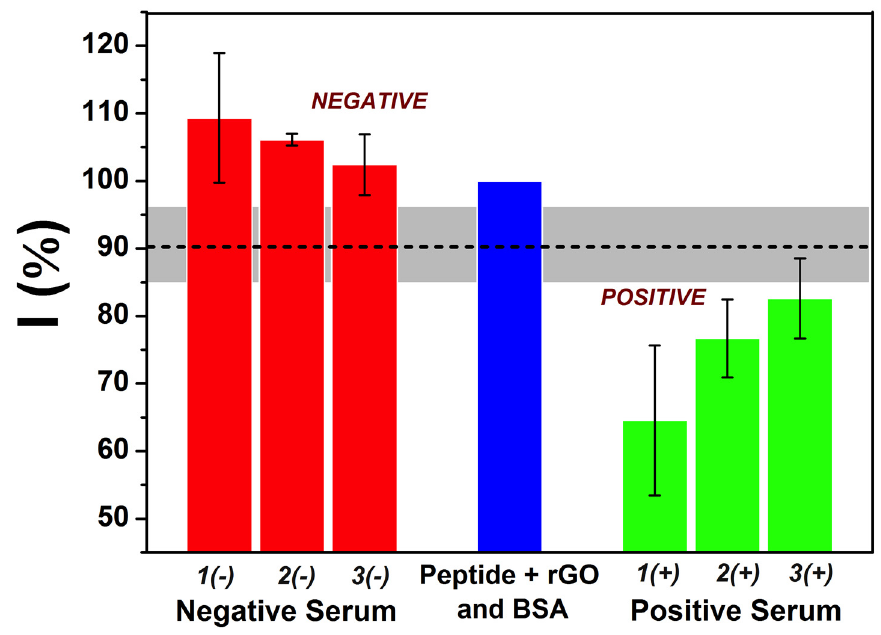
Figure 6. Summarized DPV data for assays with negative and positive human serum ( n = 3, ± SD).